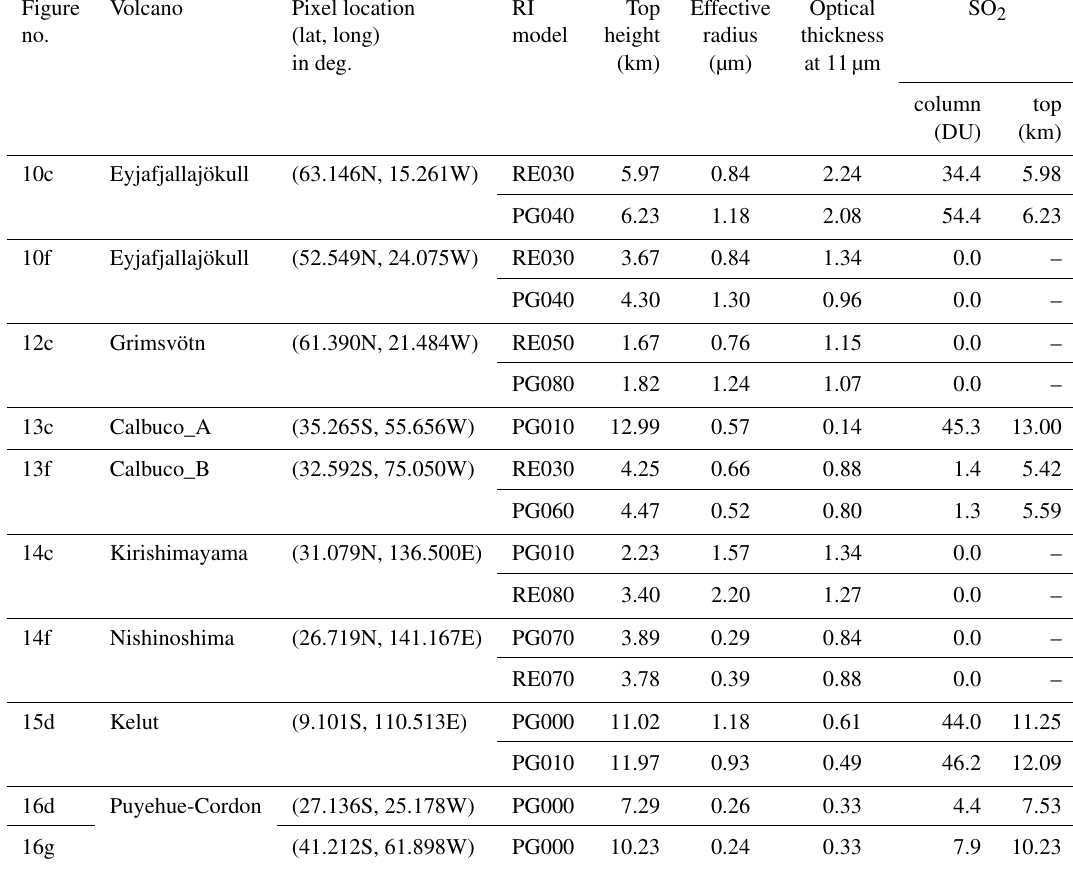
Table 3. Locations of IASI pixels, applied RI models, retrieved VAC parameters (h top ,r eff ,τ c ) , and SO 2 column (in Dobson units) and top height (km) for BTS simulations of typical VAC. BTS data for simulations and measurements are provided in the Supplement. Figure Volcano Pixel location RI Top Effective Optical SO 2 no. (lat, long) model height radius thickness in deg. (km) (µm) at 11µm